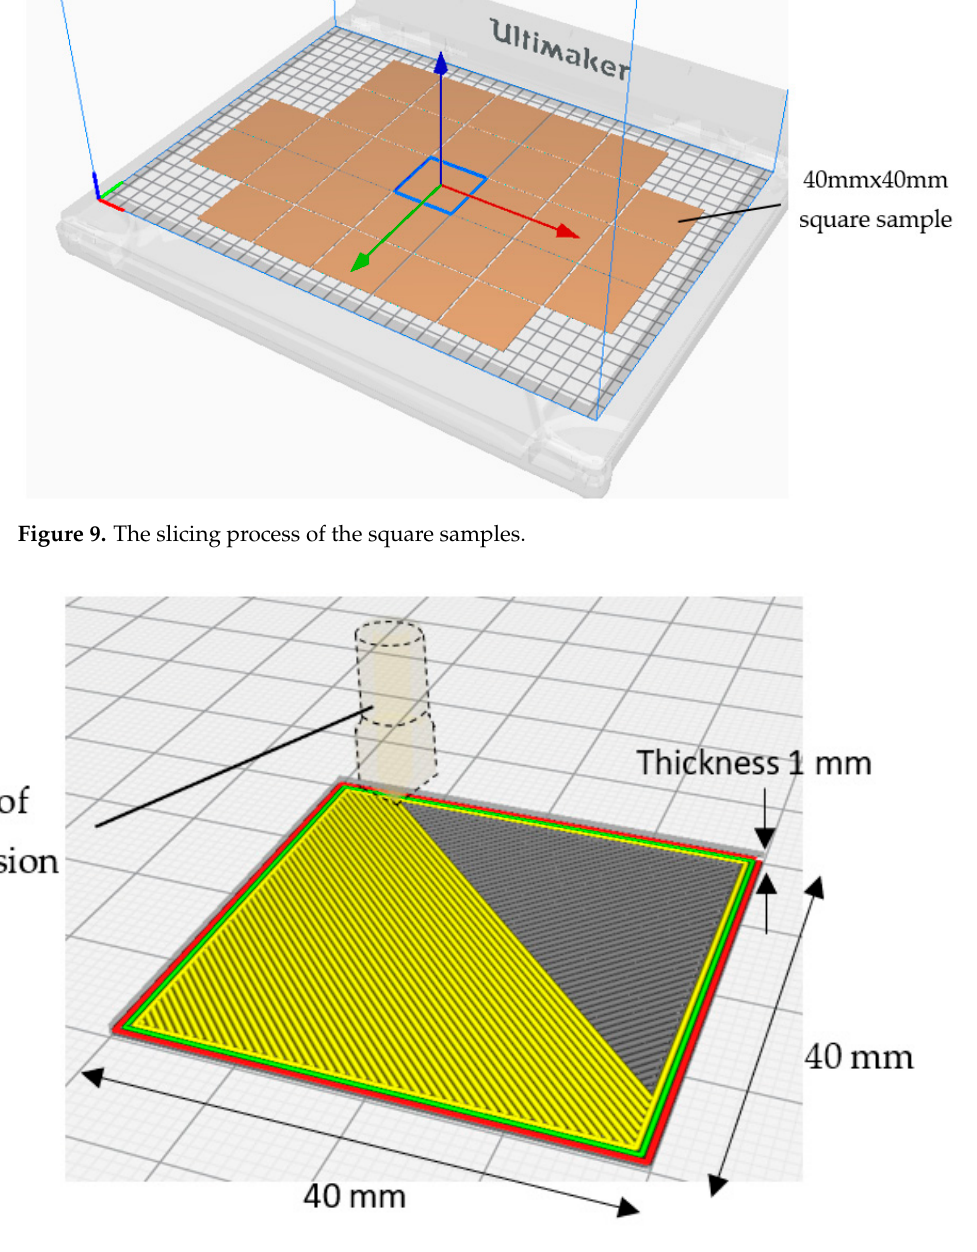
Figure 10. Slicing Simulation of the 3D printing process with the slicing features determined by the slicer Cura.